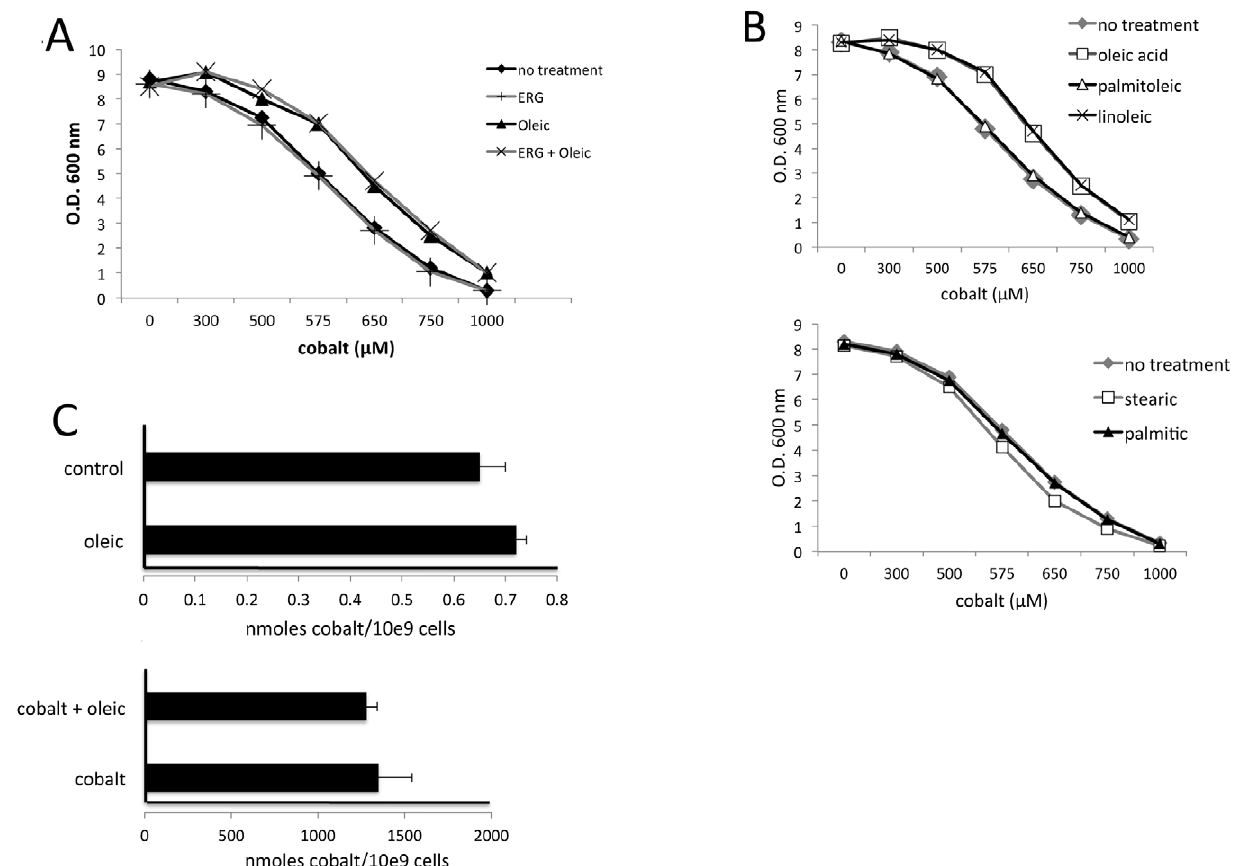
Figure 3. Effects of lipids on cobalt toxicity. A,B) Cells were grown for 18 hours in enriched YPD medium in the presence of the indicated concentrations of CoCl 2 also supplemented where indicated with (A) 15 mg/L ergosterol and/or 0.5 mM Oleic acid; and (B) 0.5 mM concentrations of the indicated unsaturated (oleic, palmitoleic and linoleic acid) or saturated (stearic and palmitic acid) fatty acids. Total growth following 18 hours was measured at an optical density at 600 nM. Results represent the averages of three independent cultures where error # 2% in all cases. C) Cells grown as in Fig. 3A in the presence of 600 m M CoCl 2 and/or 0.5 mM oleic acid were subjected to cobalt analysis by atomic absorption spectroscopy. Results represent the averages of three independent cultures and error bars represent the total range.